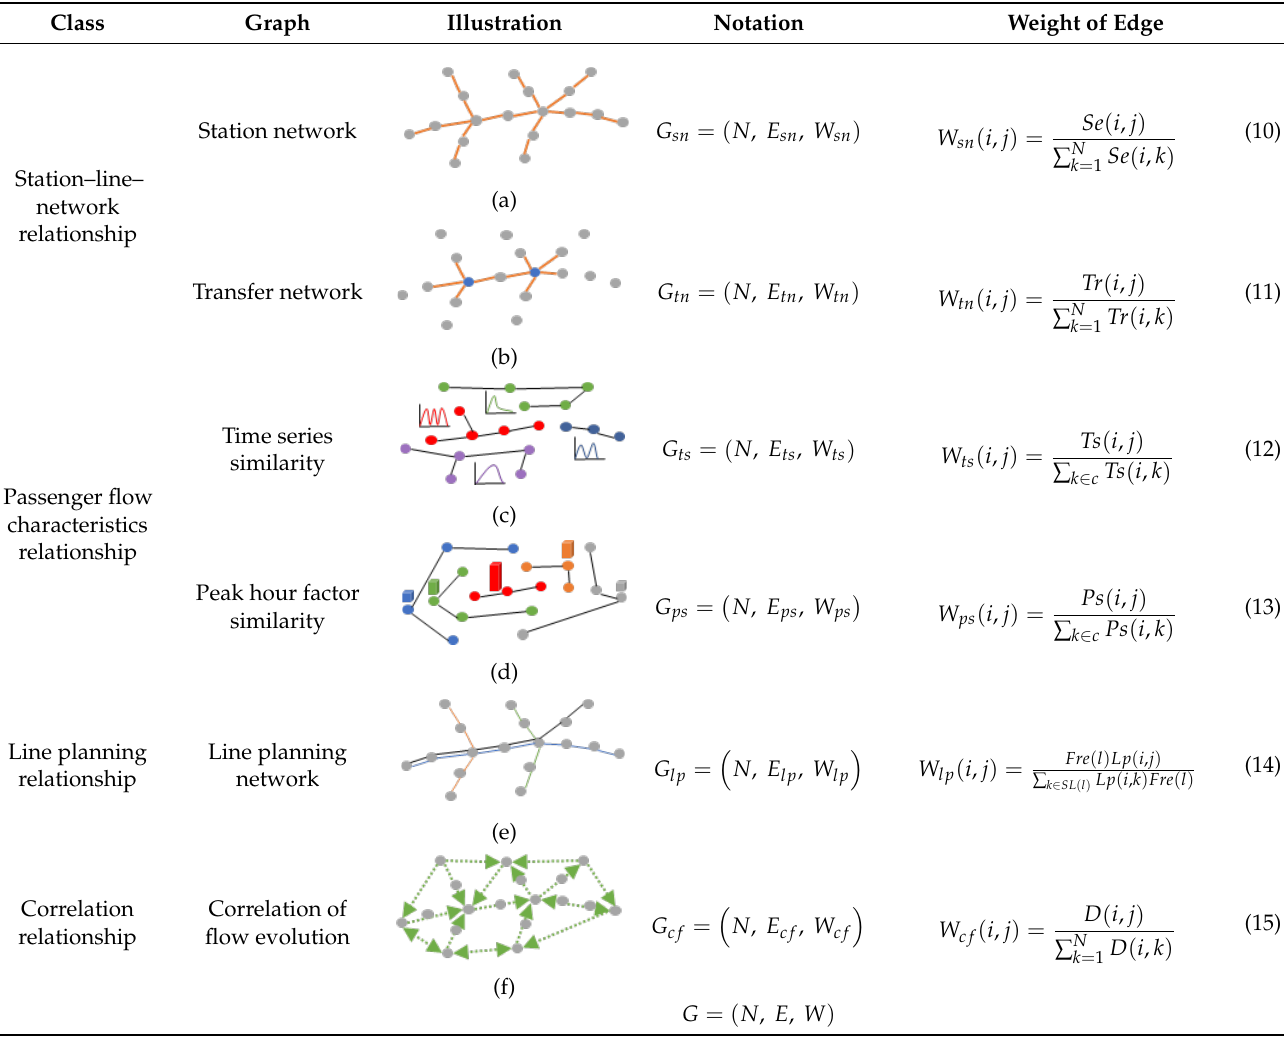
Table 3. Multi-layer networks.